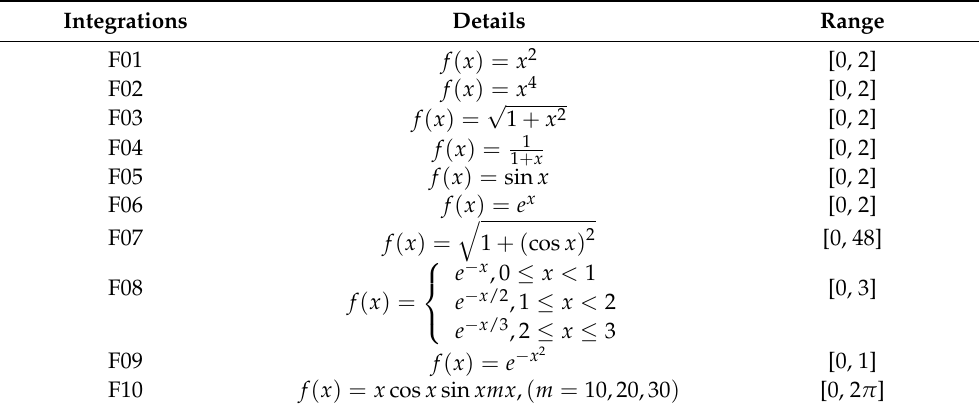
Table 8. Details of the integrations F01–F10.